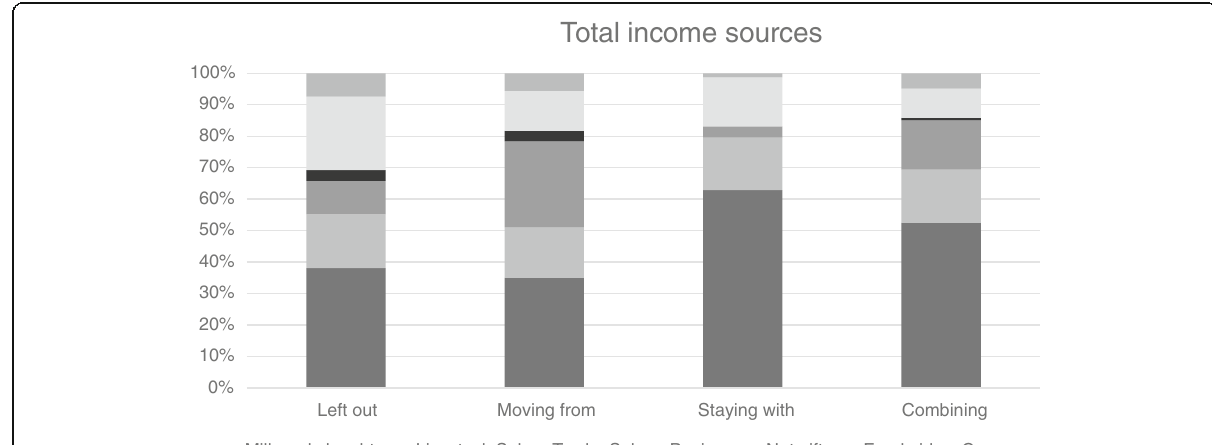
Figure 2 Total income sources by livelihood group